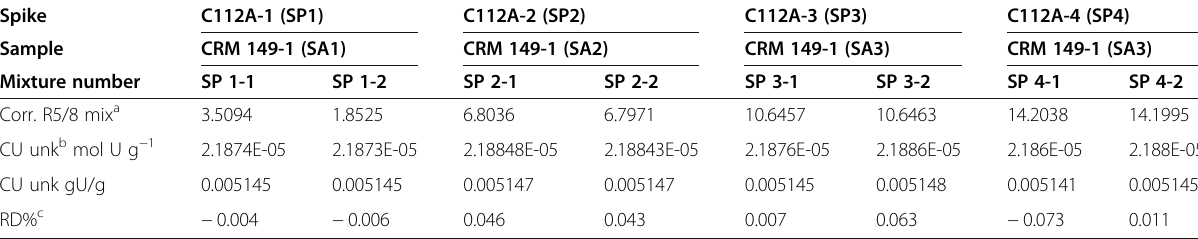
Table 5 Estimated results of the U-content for the CRM 149 sample (treated as unknown) spiked with CRM 112A original stock (SP1) and diluted spike mixtures (SP2, SP3,